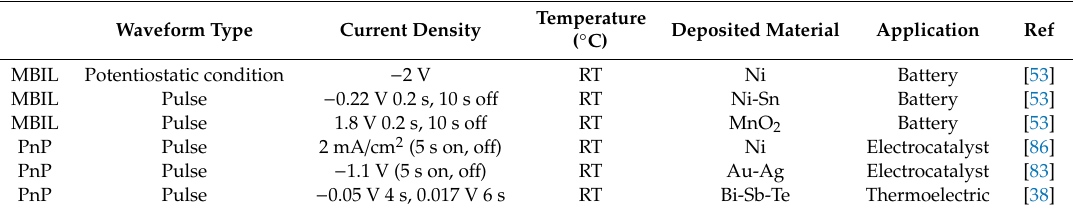
Table 2. Selected examples of 3D nanostructured template-assisted electroplating and their process